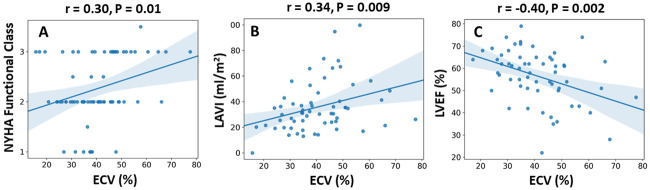
The relation between ECV fraction and functional/imaging parameters.Extracellular volume (ECV) fraction correlated positively with New York Heart Association (NYHA) functional class (A) and left atrial volume index (LAVI) (B), and negatively with left ventricular ejection fraction (LVEF) (C).